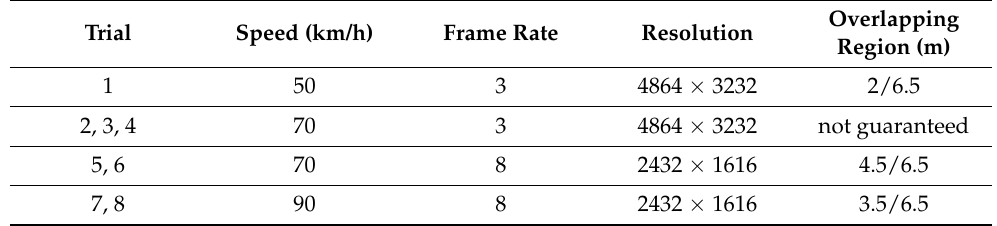
Table 1. Tests conducted to help set the values of the camera frame rate, camera resolution, and vehicle speed.